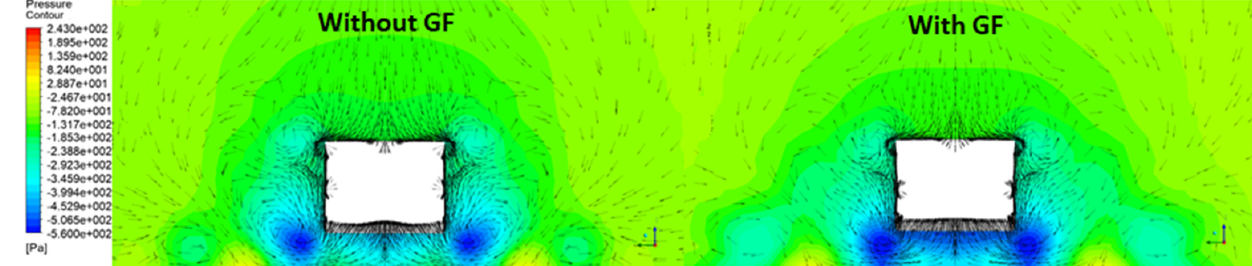
Figure 16. Comparison on the x 4 plane of pressure contours with velocity vectors. Case without ( left ) and with ( right ) GF.